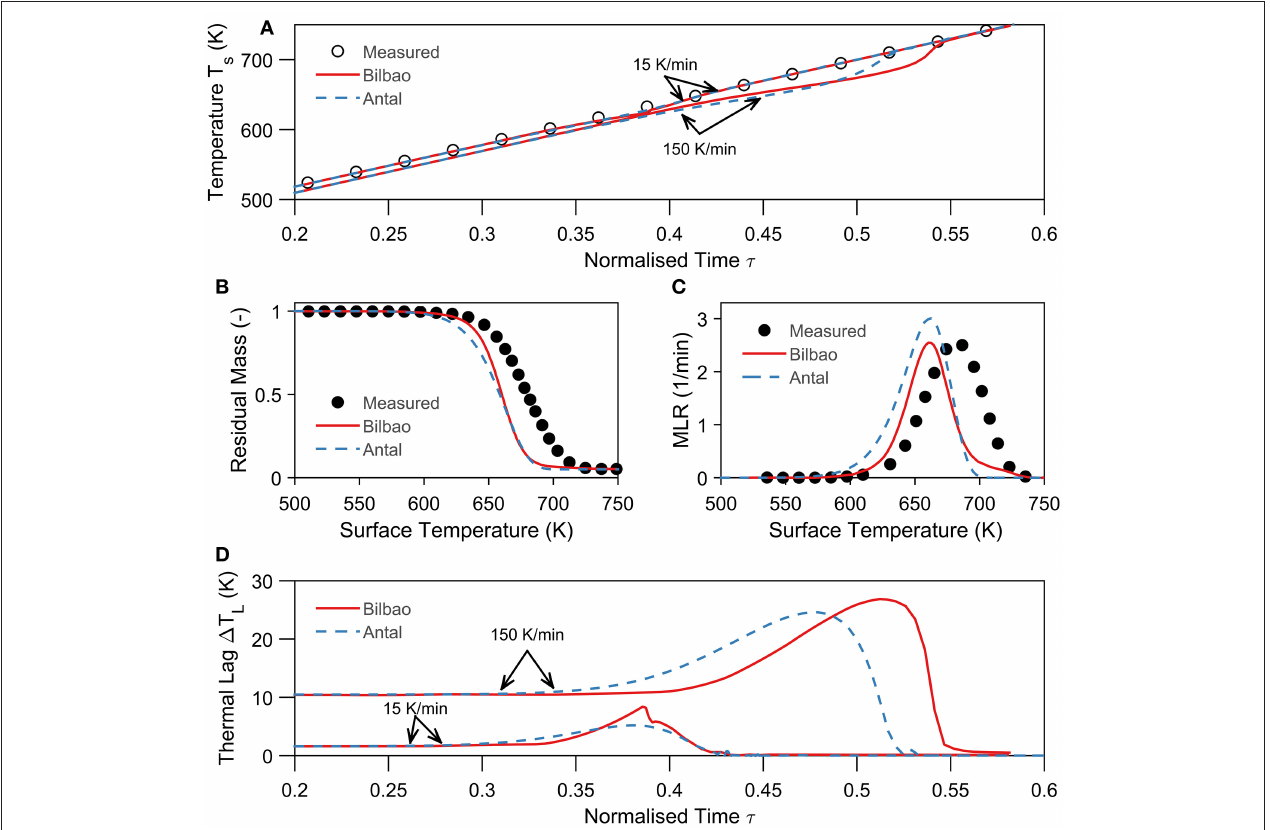
FIGURE 3 | Comparison of the Antal (kinetic model) and Bilbao (no kinetic model) method using the thermal model E. All material properties, kinetic parameters, initial conditions, and boundary conditions are taken from Lin et al. (2009) for each shown simulation. (A) Comparison between measured (Lin et al., 2009) and corrected surface temperature by the Bilbao and Antal method of a cellulose particle at 15 and 150 K/min in helium. The normalized time is defined as τ Comparison between measured ( Lin et al., 2009) and corrected residual mass–temperature history by the Bilbao and Antal method of a cellulose particle at 150 K/min in helium. (C) Comparison between measured (Lin et al., 2009) and corrected mass loss rate by the Bilbao and Antal method of a cellulose particle at 150 K/min in helium. (D) Comparison between calculated thermal lag by the Bilbao and Antal method of a cellulose particle at 15 K/min and 150 K/min in helium.